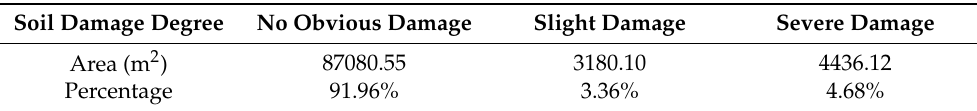
Figure 10. Evaluation results of the degree of soil damage based on the buffer. Table 8. The statistical results of the degree of soil damage